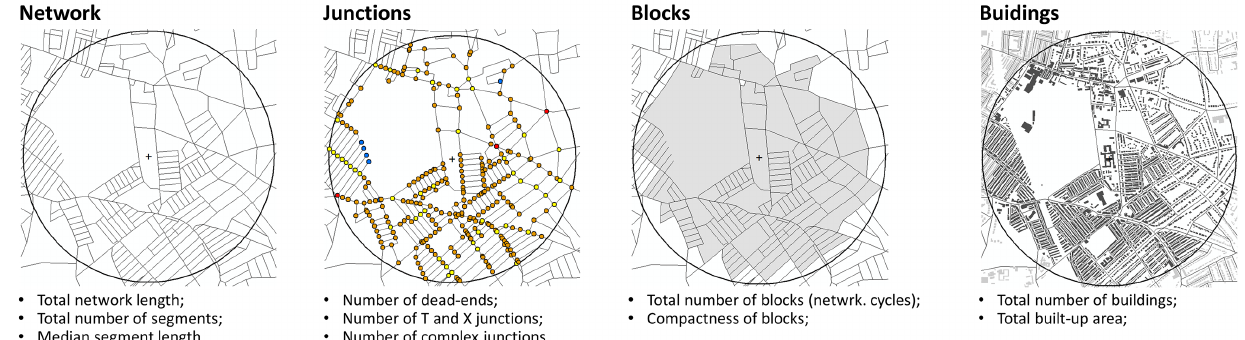
Figure 6. Graphic depiction of the adopted morphological indicators. considered without jeopardizing the workings of the pro- posed method. The full list of the morphological indica- tors used in this study is as follows: a) Network attributes: total network length (me- ters), total number of segments (straight street stretches) and ratio between the number of junc- tions and the number of segments. b) Junction attributes: total number of junctions; number of T-junctions (three segments junction); number of X-junctions (four segments junction); number of complex junctions (more than four seg- ments) and number of dead-ends. c) Block attributes: total number of blocks (i.e., re- gions of space bounded by streets) and compact- ness of blocks (standardized area/perimeter ratio, yielding 1 for a circle and values close to 0 for thin, elongated